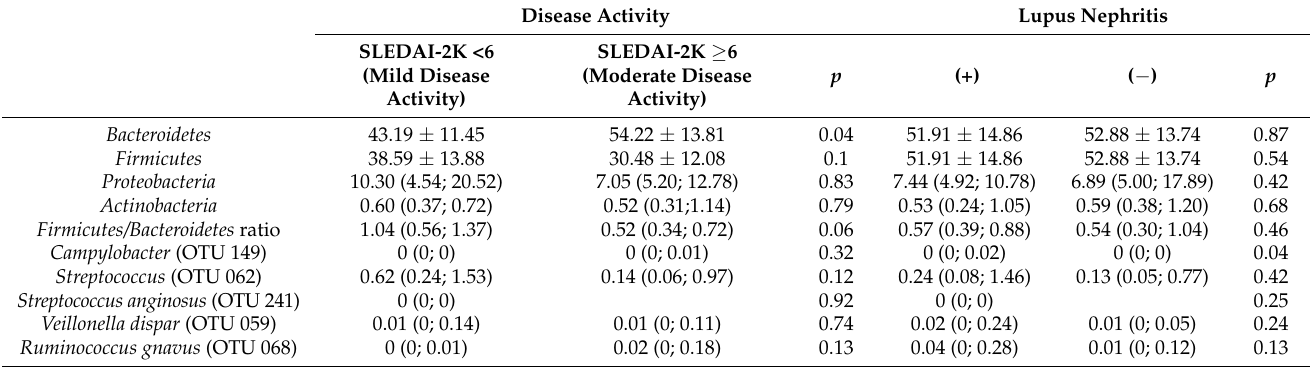
Figure 4. Changes of alpha diversity parameters: ( a ) Richness index; ( b ) Chao 1 index; and ( c ) Shannon index in the synbiotic and placebo groups. Table 3. Comparison of some variables according to disease activity and renal